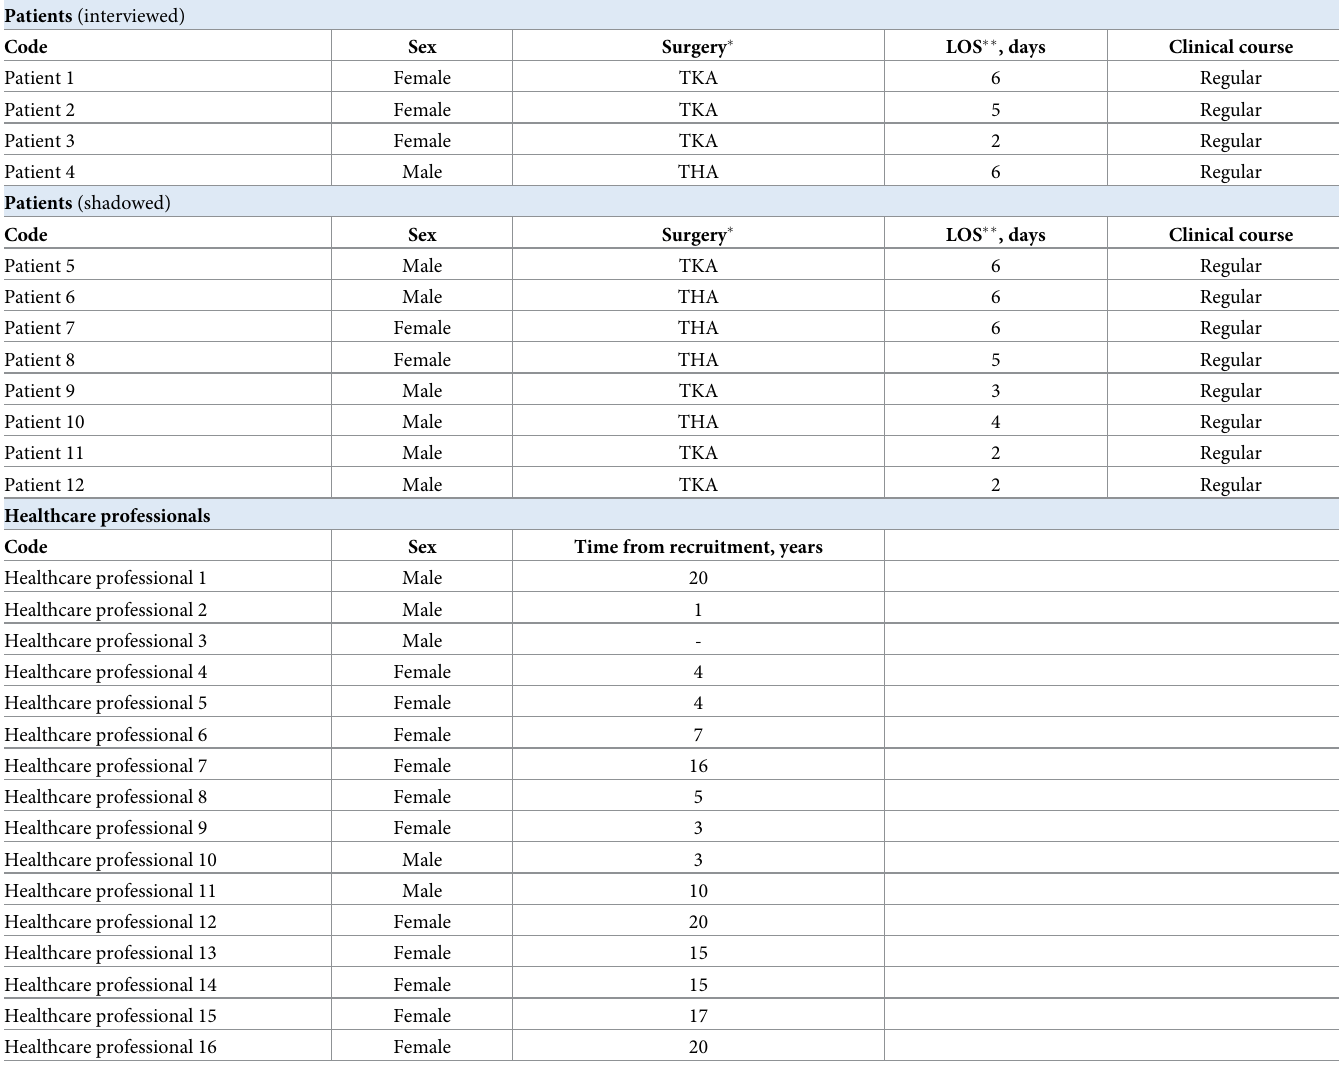
Table 2. Main characteristics of participant involved in the